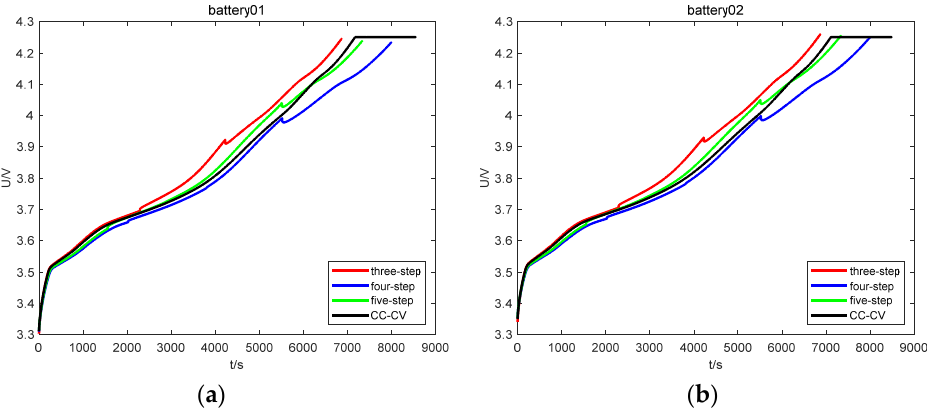
Figure 15. Voltage comparison diagrams between the optimized charging strategy and the constant current—constant voltage charging strategy: ( a ) Battery01; ( b ) Battery02.